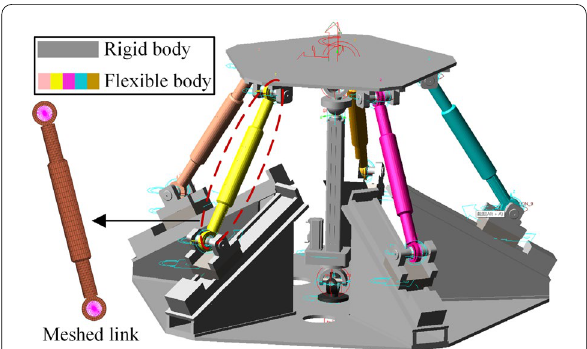
Figure 10 Rigid-flexible coupling model of parallel mechanism